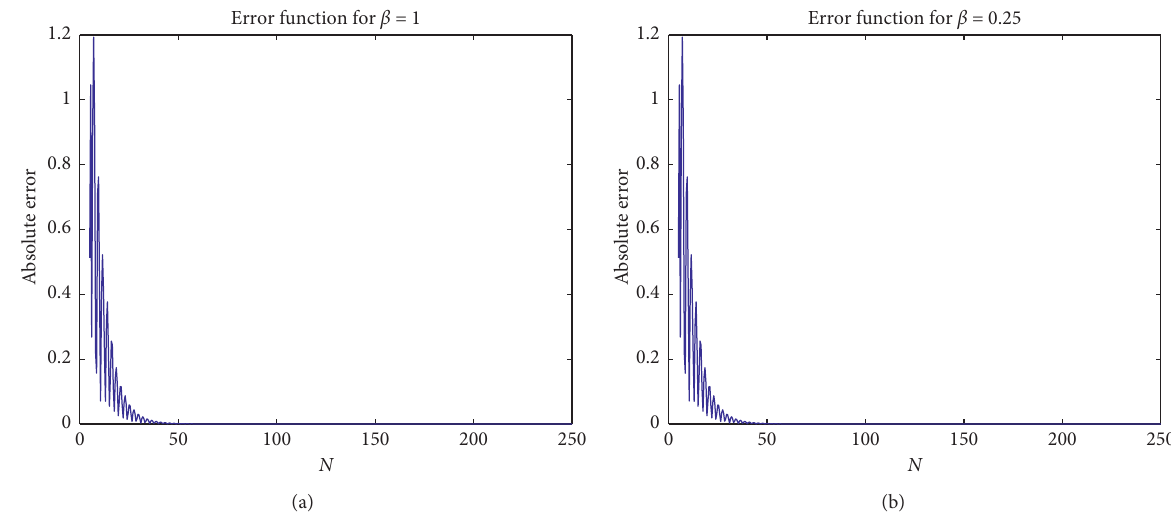
Figure 2: (a) The error function for fractional order β � 1. (b) The error function for β � 0 . 25 corresponding to Problem 1.